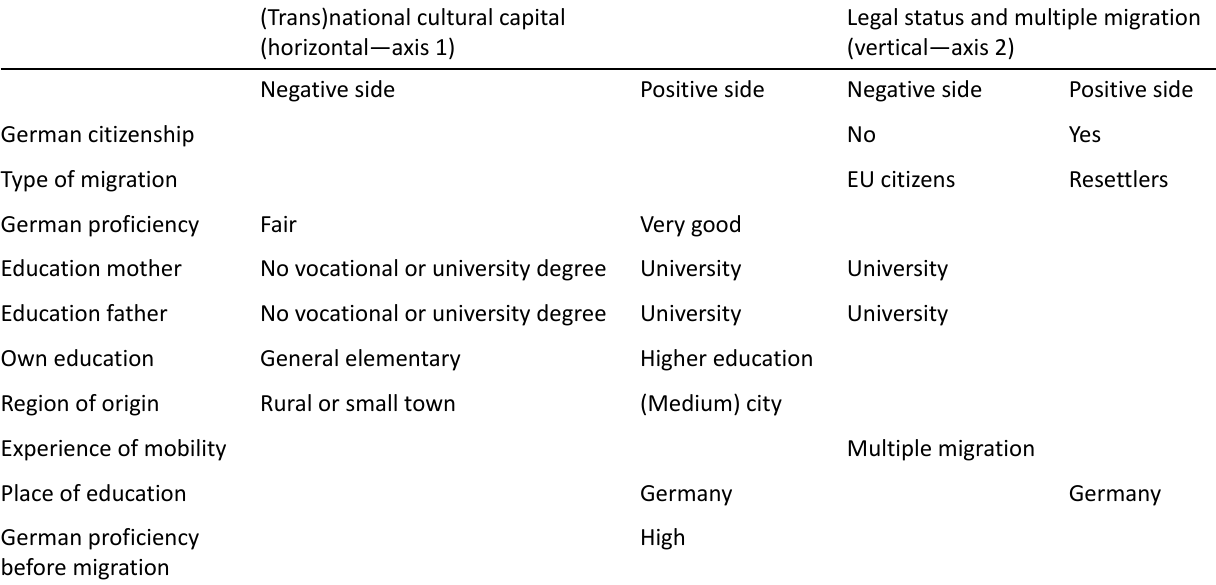
Table 2. Contributions of the (active) modalities to the first two